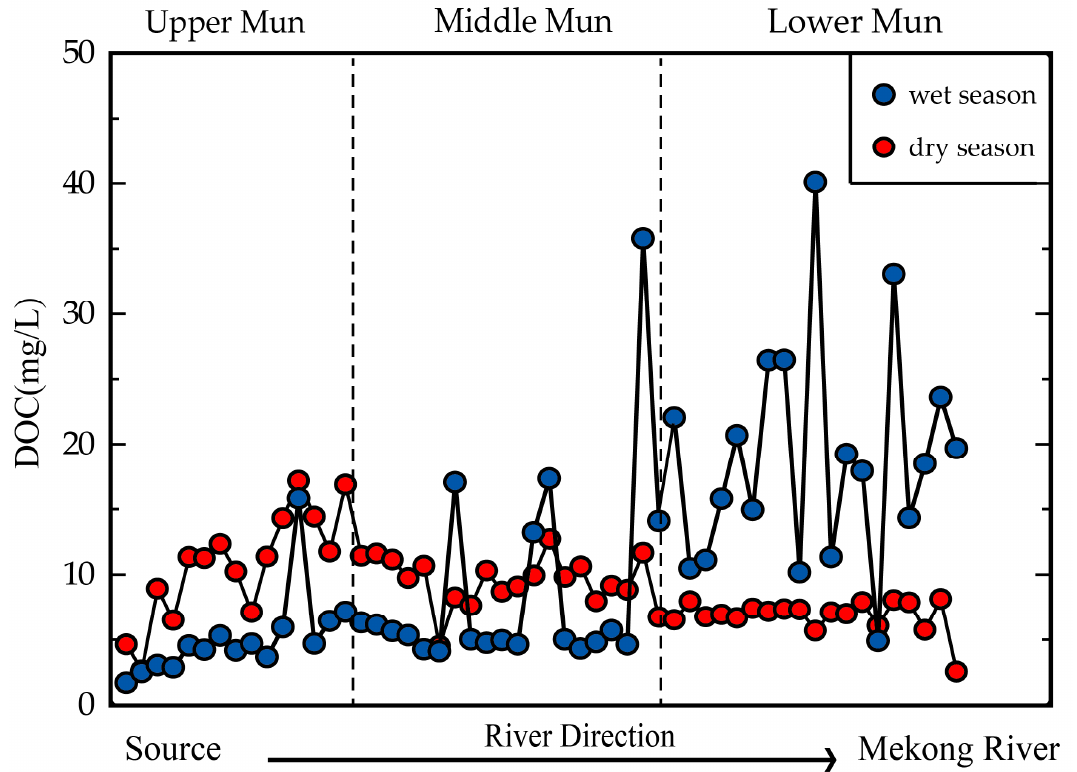
Figure 7. Temporal and spatial distributions of DOC in Mun River waters.